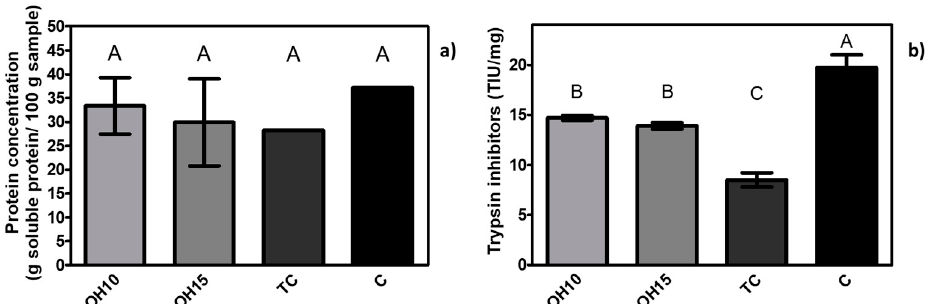
Figure 2. ( a ) Protein concentration and ( b ) trypsin inhibition for each flour sample. OH10: 110 °C / 10 min, OH15: 110 °C / 15 min, TC: traditional cooking, C: crude. Each value represents the mean of two replicates ± DS. Values with the same letter are not different from each other (Tukey α =